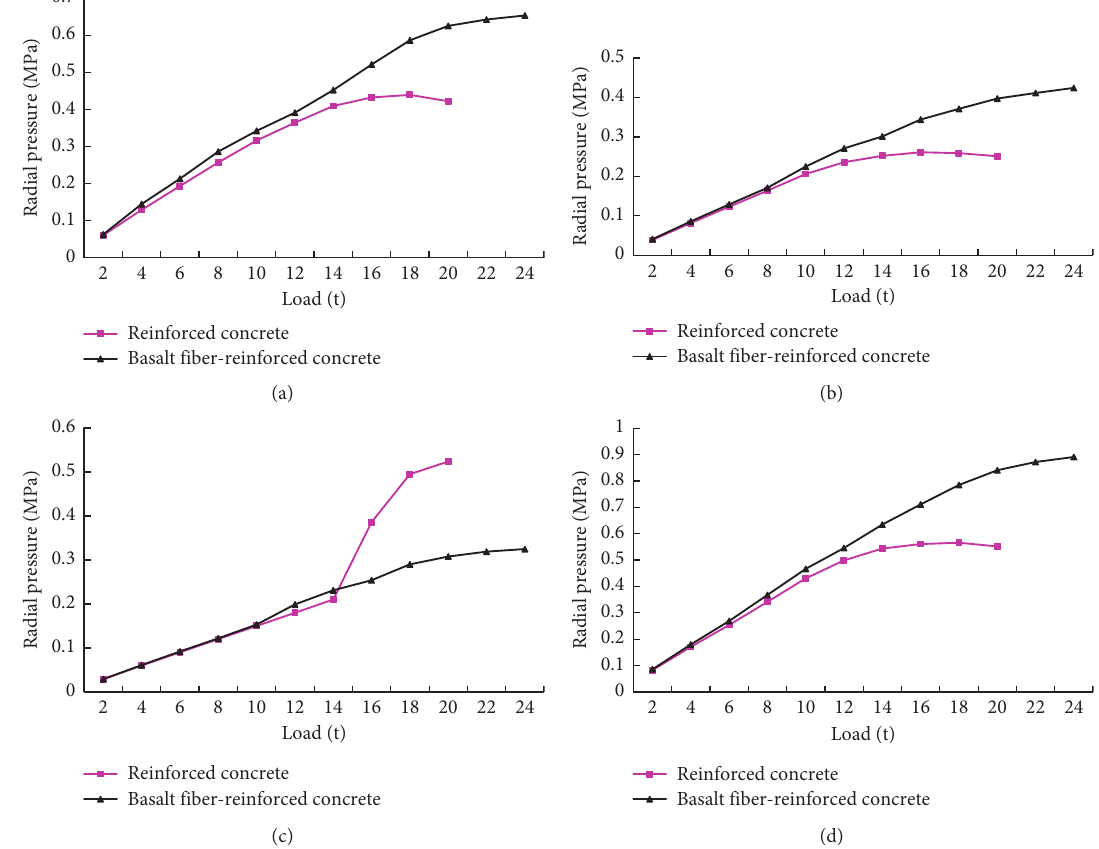
Figure 12: Change curve of the radial pressure and load. (a) Measuring point 1-vault, (b) measuring point 2-haunch, (c) measuring point 3- middle of side wall, and (d) measuring point 4-middle of inverted